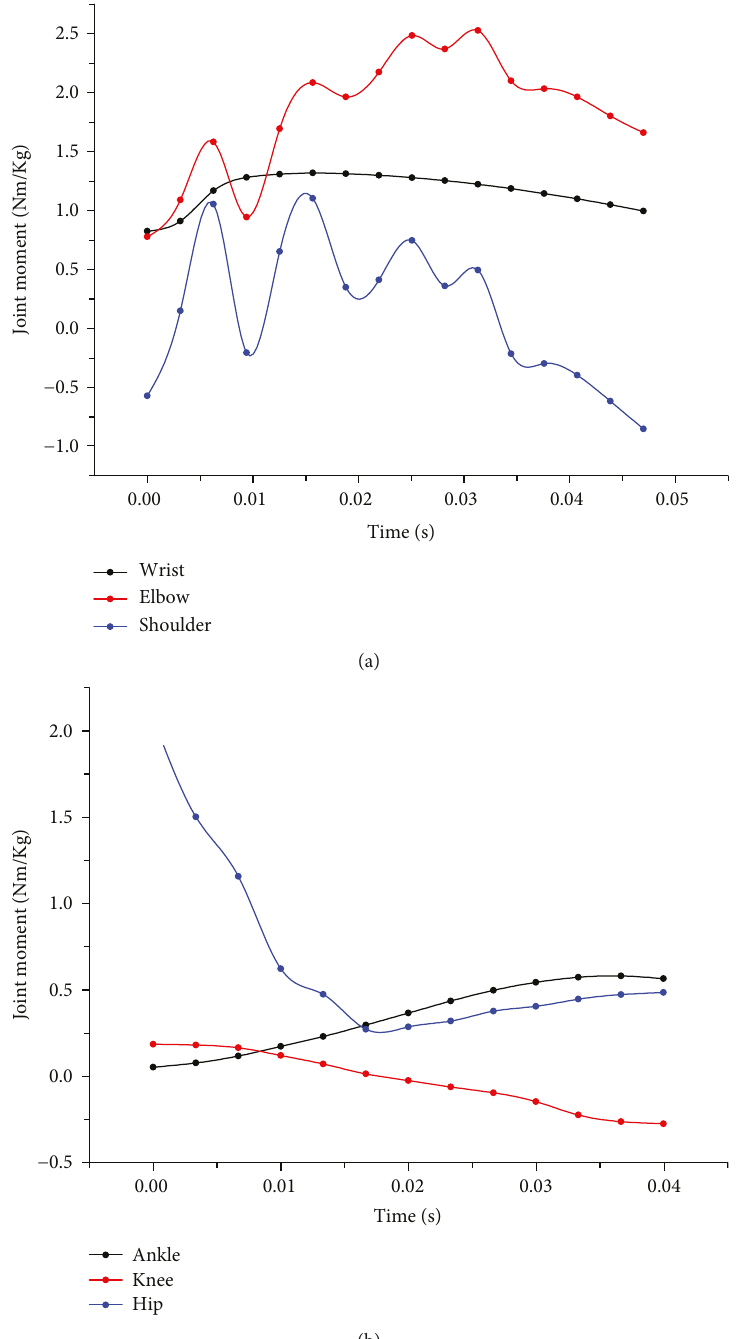
Figure 6: Joint moment in (a) the RF wrist, elbow, and shoulder joints and (b) the RH ankle, knee, and hip joints during landing from a 1.2m